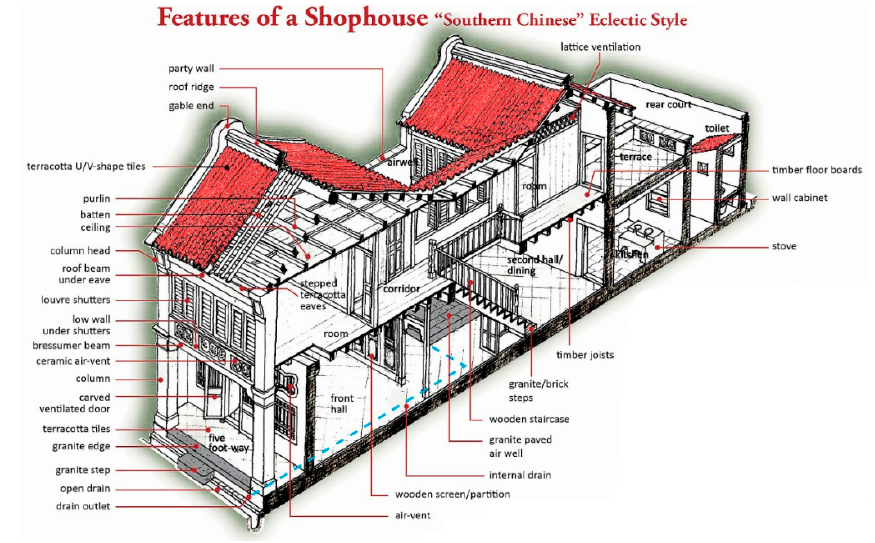
Figure 2. Section of a typical Chinese shophouse demonstrated by Tan [17].